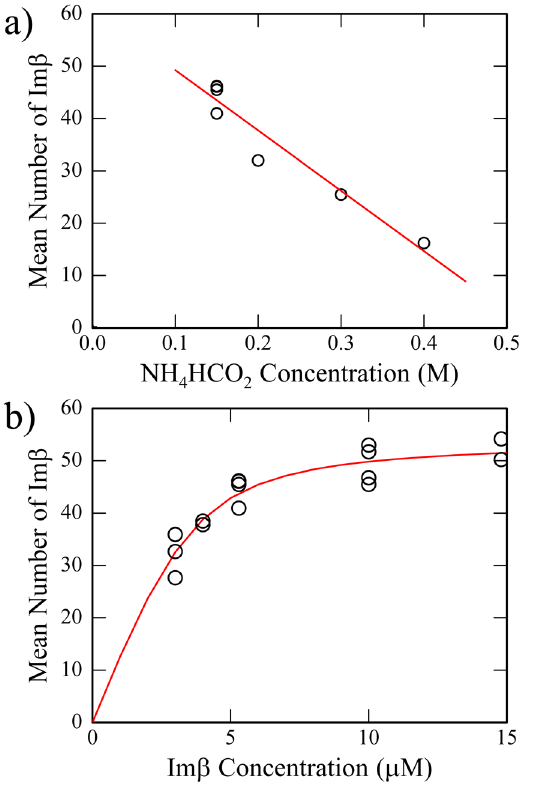
Fig 5. CDMS quantification of Imp β -capsid complexes indicates saturable, ionic strength-sensitive binding of Imp β . (a) The mean number of Imp β bound to Cp183 capsids decreases as a function of NH 4 HCO 2 concentration. The Imp β concentration was 5.3 μ M and the concentration of Cp183 was (7.9 μ M dimer, 66 nM capsid). (b) The average number of Imp β bound to HBV Cp183 capsids increases as a function of Imp β concentration. All samples used in this titration were in 150 mM ammonium formate. The binding isotherm fit to these data suggests that up to 50 Imp β bind per capsid with a dissociation constant of about 2.5 μ